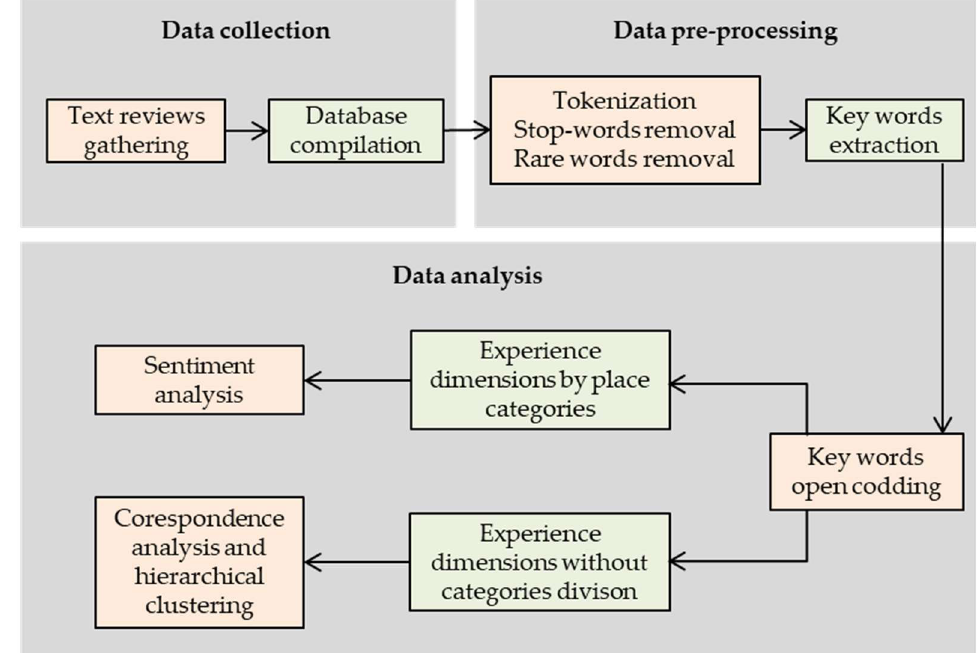
Figure 1. Proposed research